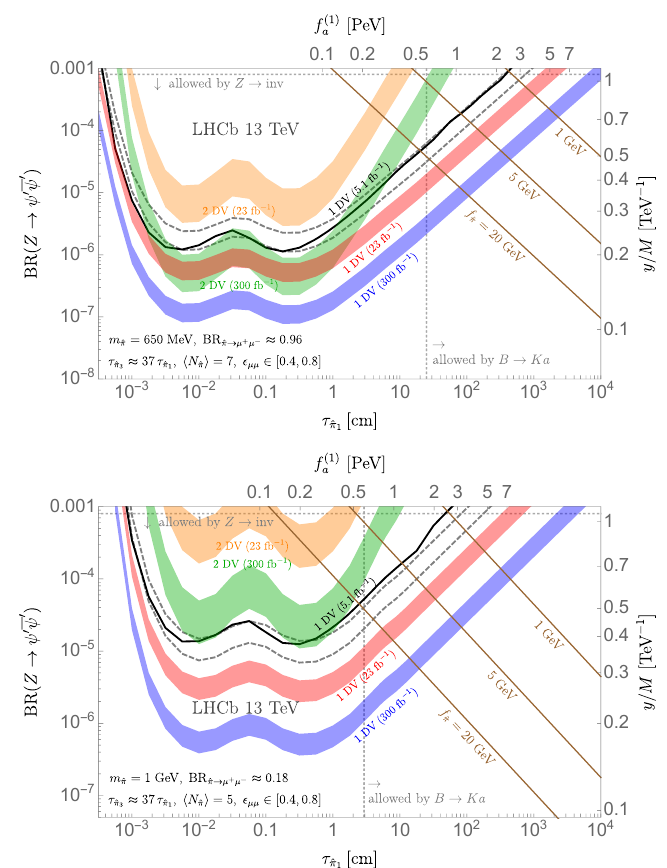
Figure 7 . Projection of the 90% CL LHCb sensitivity [84] to Z -initiated, muon-rich dark showers for m = 650 MeV (top) and m = 1 GeV (bottom) . The two minima of the exclusion contours ˆ π ˆ π correspond to optimal sensitivity to decays of two dark pion species with different lifetimes, ˆ π 1 and ˆ π , while decays of the longest-lived ˆ π are neglected. The current exclusion is shown by the 3 2 black curve, while the widths of all other bands are obtained by varying the single-DV efficiency 0 ) and obtained from (cid:15) µµ ∈ [0 . 4 , 0 . 8] . Brown lines indicate the relation between BR( Z → ψ 0 ψ τ ˆ π 1 benchmark scenario 1, for representative choices of f ˆ π